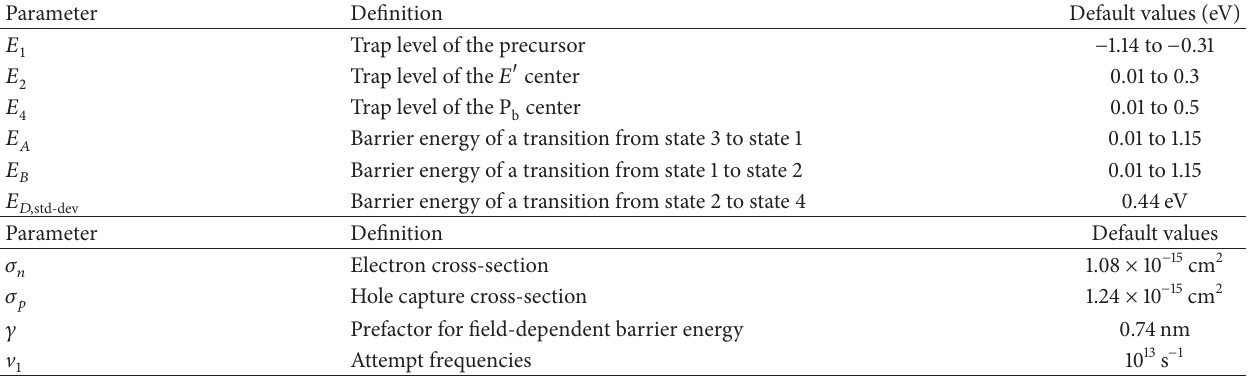
Table 2: Default spread of energy wells and barriers used in simulation [16,